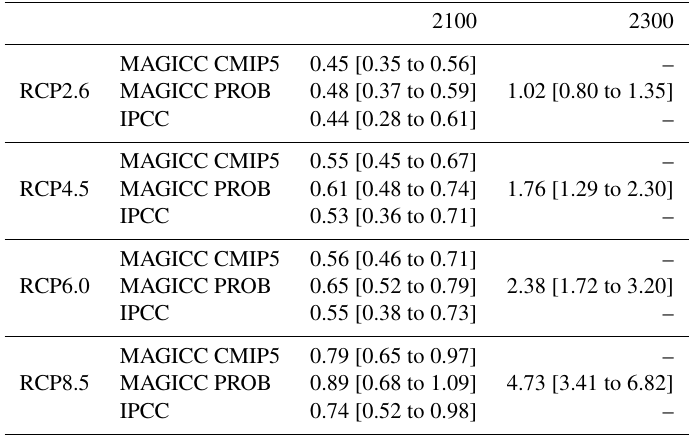
Table 7. The 2100 and 2300 median values as well as 66% ranges for total global SLR projections relative to 1986–2005 based on the MAGICC CMIP5 and MAGICC PROB experimental designs. IPCC median projections and likely ranges are given as a reference.